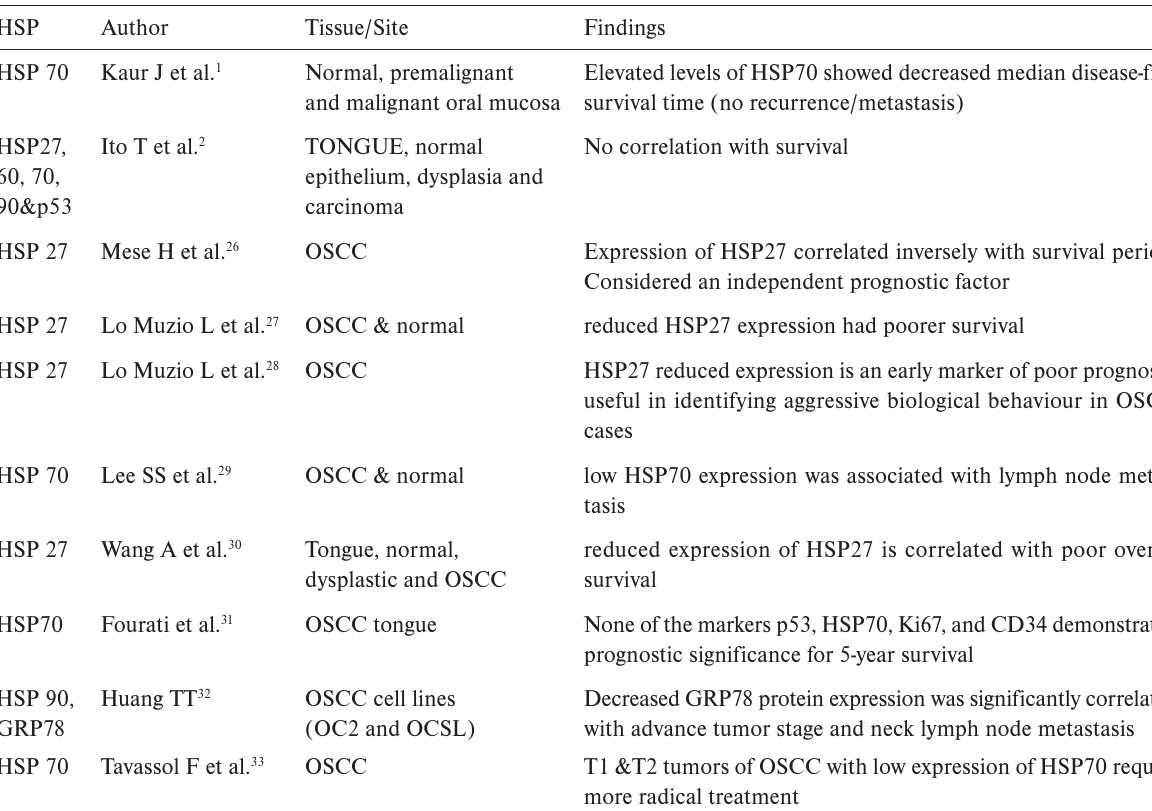
Table 2. Implications in prognosis of oral